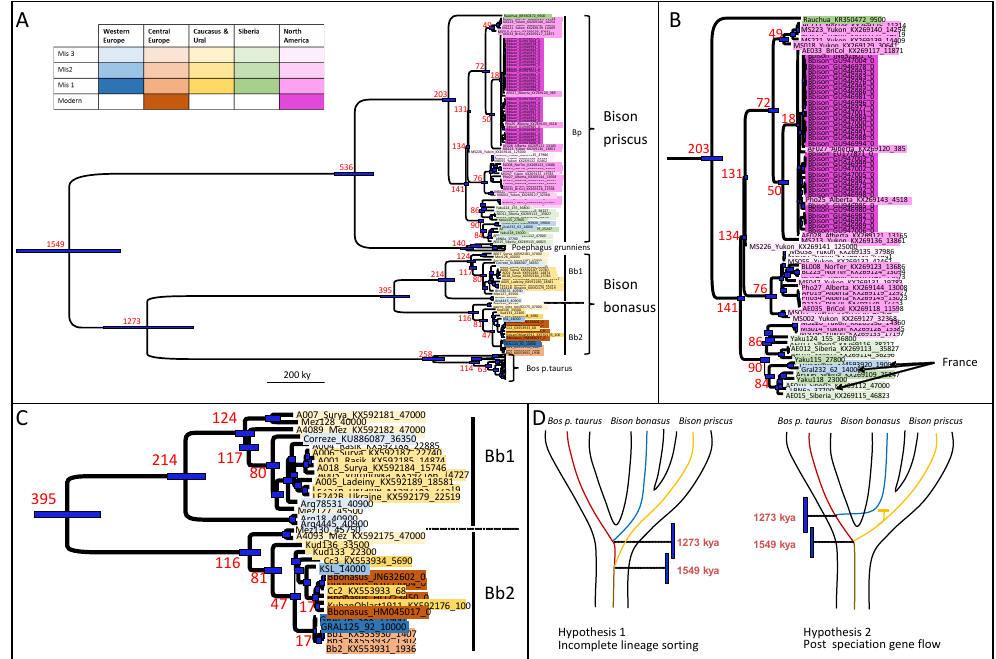
Figure 1. Bayesian phylogeny of complete mitogenomes of Bos and Bison . We used the 86 complete mitogenomes of ancient Bison available in Genbank at the end of 2017, and all 420 modern Bison bison , Bison bonasus , Poephagus grunniens , and Bos primigenius taurus mitogenomes available in Genbank in 2015. The B. bison , P. grunniens and B. p. taurus sequences have been collapsed to preserve only their subclade structure. The estimates of the age of the nodes, in kya, are indicated in red, with the 95% HPD indicated by blue bars. The statistical supports of the nodes are indicated in red (Bayesian posterior probability). Sequence names were colored according to period and geographical origins of the samples following the color code depicted in the table insert in panel A. ( A ) Complete Bovina mitogenome tree. ( B ) Enlarged view of the Bison priscus / bison part of the tree. ( C ) Enlarged view of the Bison bonasus part of the tree. ( D ) Schematic representation of the two hypotheses describing the mtDNA segregation pattern between B. p. taurus , B. bonasus and B. priscus /